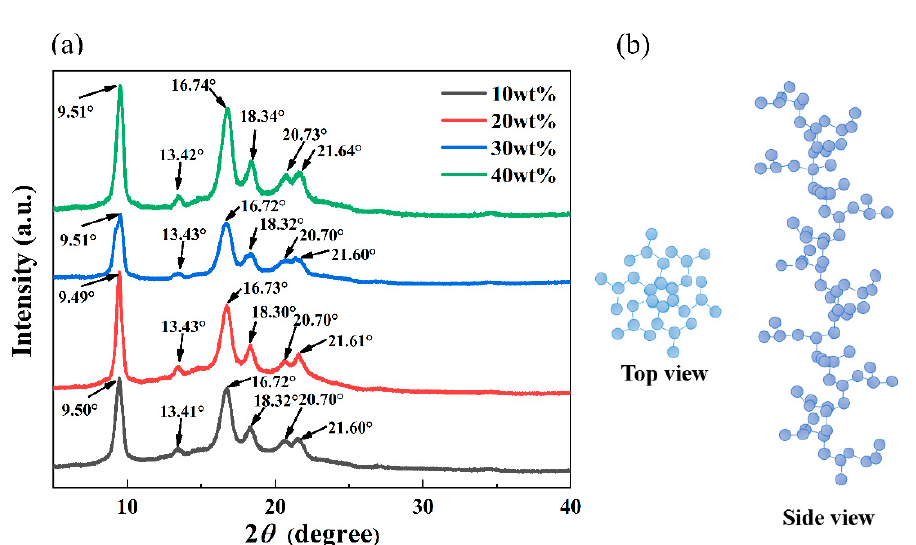
Figure 5. ( a ) the X-ray diffractograms of the PMP-MA system prepared with different PMP concentrations; ( b ) a schematic diagram of the top and side views of the carbon chain conformation in the crystalline phase of PMP [50].